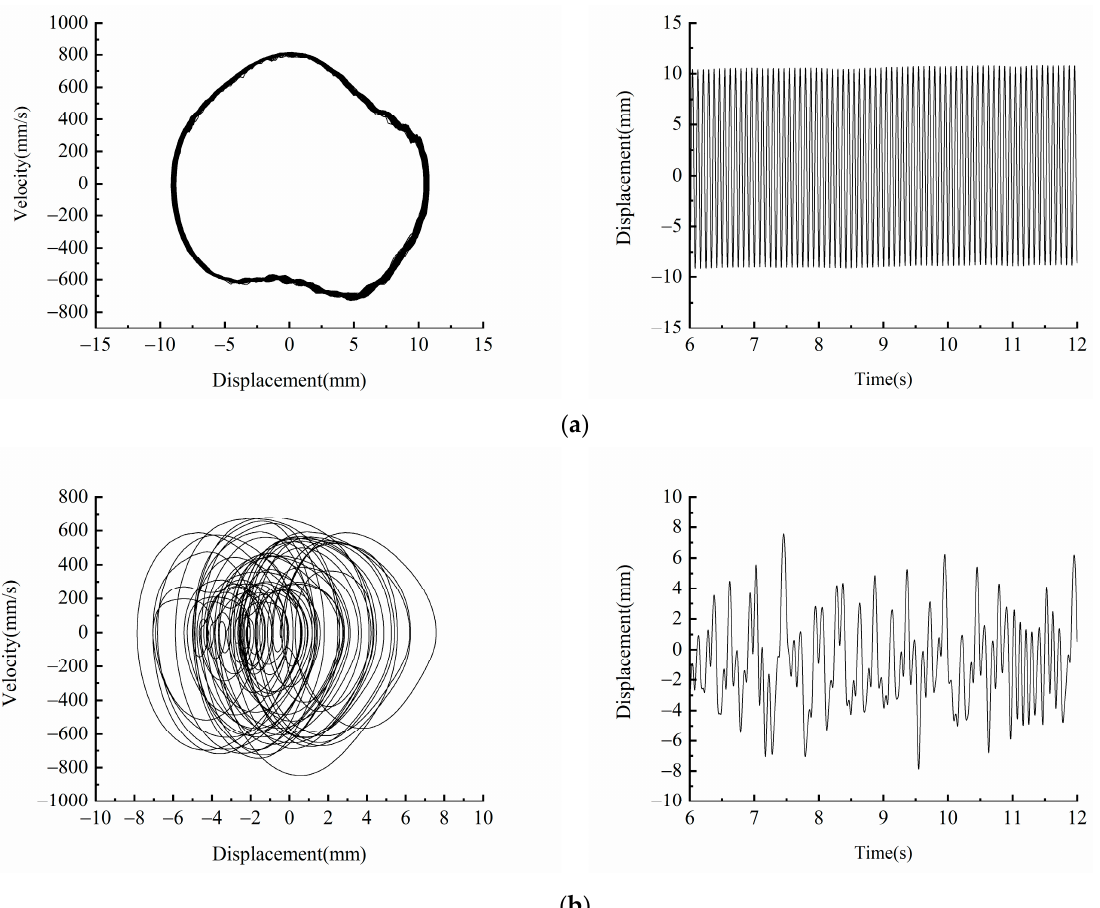
Figure 12. Experimental phase portrait and time-displacement diagram of different excitation fre- quency: ( a ) 𝑓 = 8 Hz ; ( b ) 𝑓 = 12 Hz .